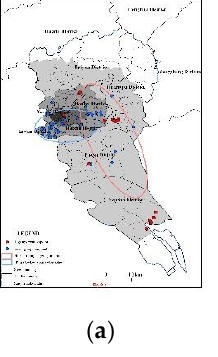
Figure 9. The standard deviation ellipses for carbon emissions from equipment in Guangzhou: ( a ) water heating equipment; ( b ) kitchen equipment; ( c ) refrigeration equipment; ( d ) large household appliances; ( e ) lighting equipment.